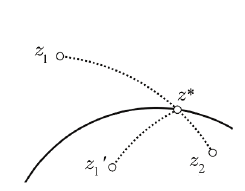
and z ∗ is image by reflection of the segment joining z 0 1